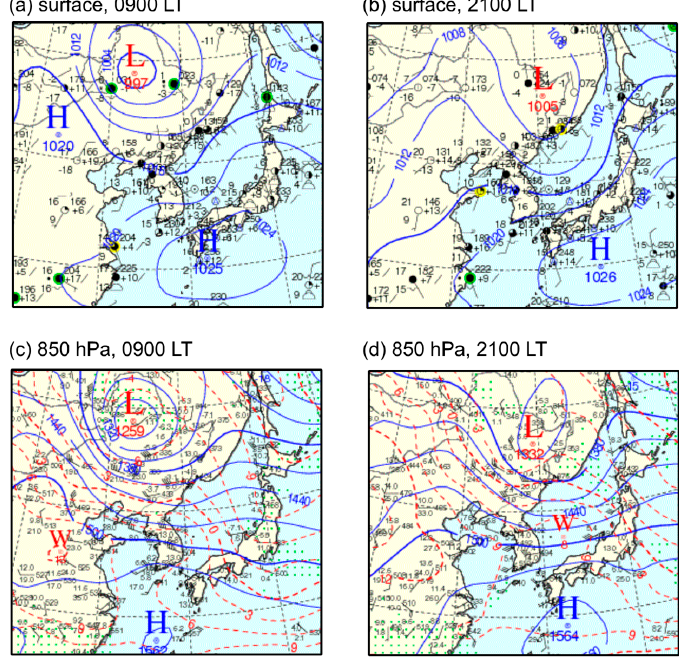
Figure 1. Surface weather charts at ( a ) 0900 LT and ( b ) 2100 LT and 850-hPa weather charts at ( c ) 0900 LT and ( d ) 2100 LT on 8 April 2012. In ( a ) and ( b ), the mean sea-level pressure (blue solid lines) is contoured in 4 hPa intervals. In ( c ) and ( d ), the geopotential height (blue solid lines) is contoured in 30 gpm intervals and the temperature (red dashed lines) is contoured in 3 °C intervals. These weather charts are provided by the Korea Meteorological Administration [20]. The yellow and green marks on the cloud coverage symbol in ( a ) and ( b ) represent the fog and rain, respectively. On 8 April 2012, the 10-m maximum instantaneous wind speed is 11.3 m s − 1 at Osan station and 22.2 m s − 1 at Yangyang station, showing a large difference in wind speed between the upstream and